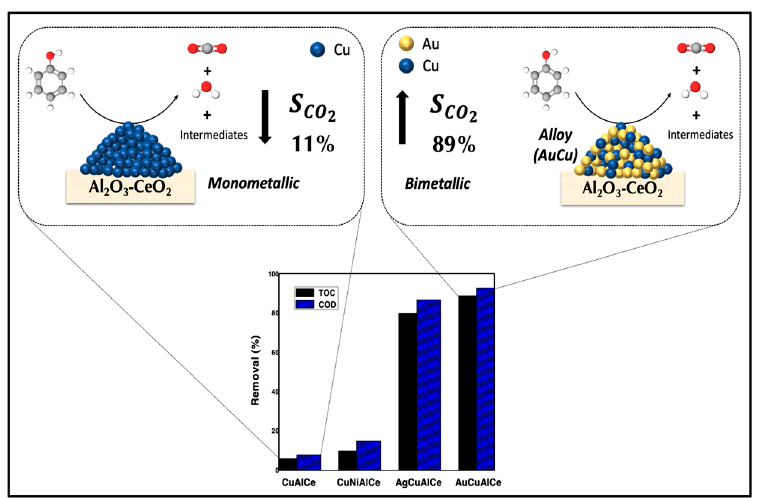
Figure 19. Scheme proposed to compare catalytic performance of phenol degradation with monometallic CuAlCe versus bimetallic catalyst AuCuAlCe.